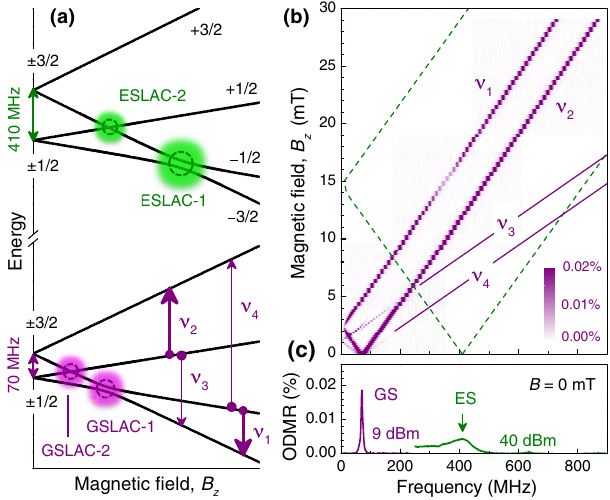
FIG. 1. (a) The GS ( 2 D ¼ 70 MHz) and ES ( 2 D 0 ¼ 410 MHz) spin sublevels of the V point defect in external magnetic field Si ∥ c , assuming a weak perpendicular component B ≪ B B . The ⊥ z z vertical arrows indicate rf-driven spin transitions, their thick- nesses mirroring the contrasts of the corresponding ODMR lines. The magnetic field evolutions of the GS and ES are shown schematically, i.e., not to scale. (b) Magnetic field versus frequency evolution of the V ODMR signal recorded at room Si temperature and at low rf power. The solid and dashed lines are 2 the positions of the ODMR peaks calculated for the Δ m S ¼ (cid:2) 1 transitions in the ES, transitions in the GS and Δ m S ¼ (cid:2) respectively. (c) Low-rf-power (9 dBm) and high-rf-power (40 dBm) ODMR spectra in zero magnetic